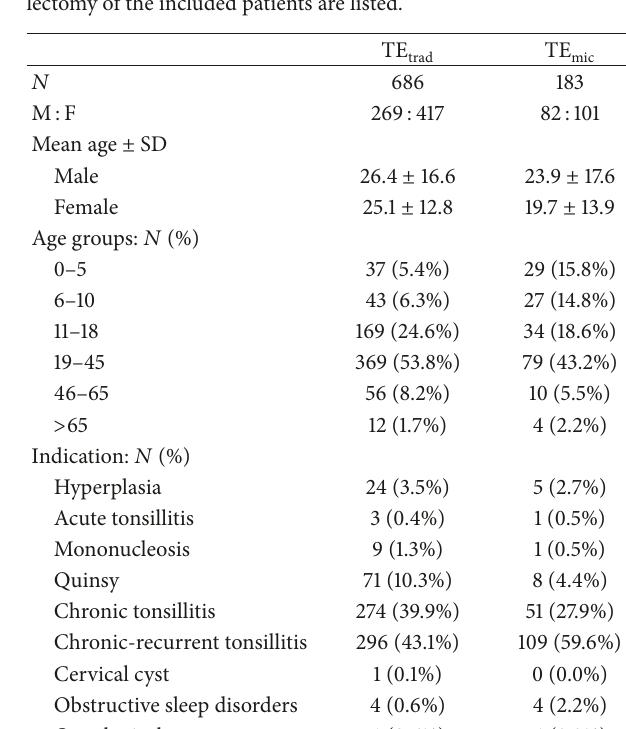
Table 2: Demographic data, age groups, and indications for tonsil- lectomy of the included patients are